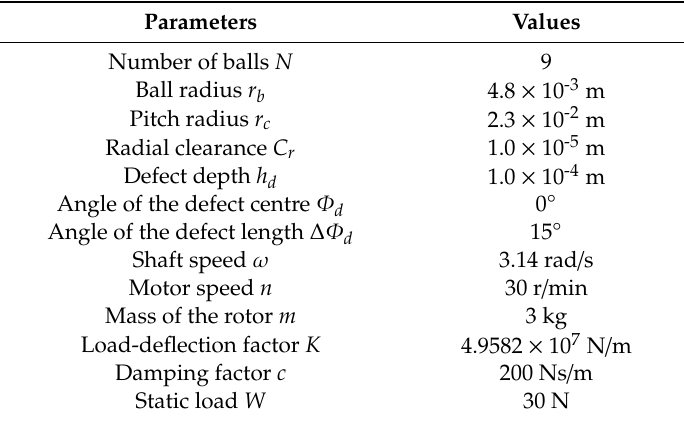
Table 1. Parameters of Bearing Dynamic Model (based on SKF